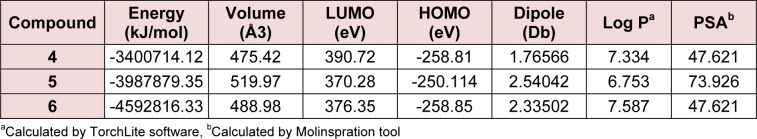
Comparison of quantum-chemical and physicochemical properties of steroidal oximes (4-6).